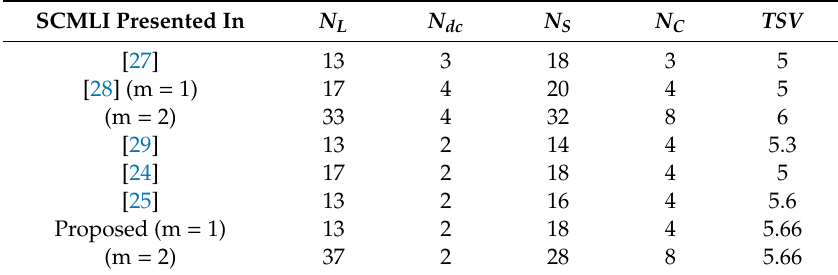
Table 4. Comparison of proposed topology with other symmetric SCMLI.